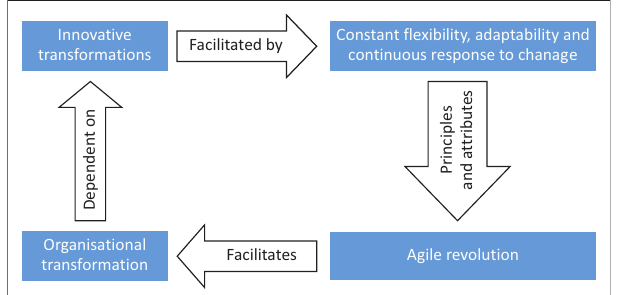
FIGURE 2: Literature review